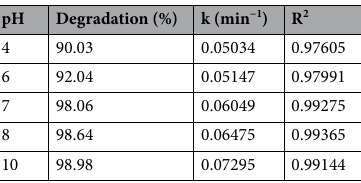
Table 4. Evaluation of various parameters for optimization of pH of the photocatalysis environment for MG dye degradation.